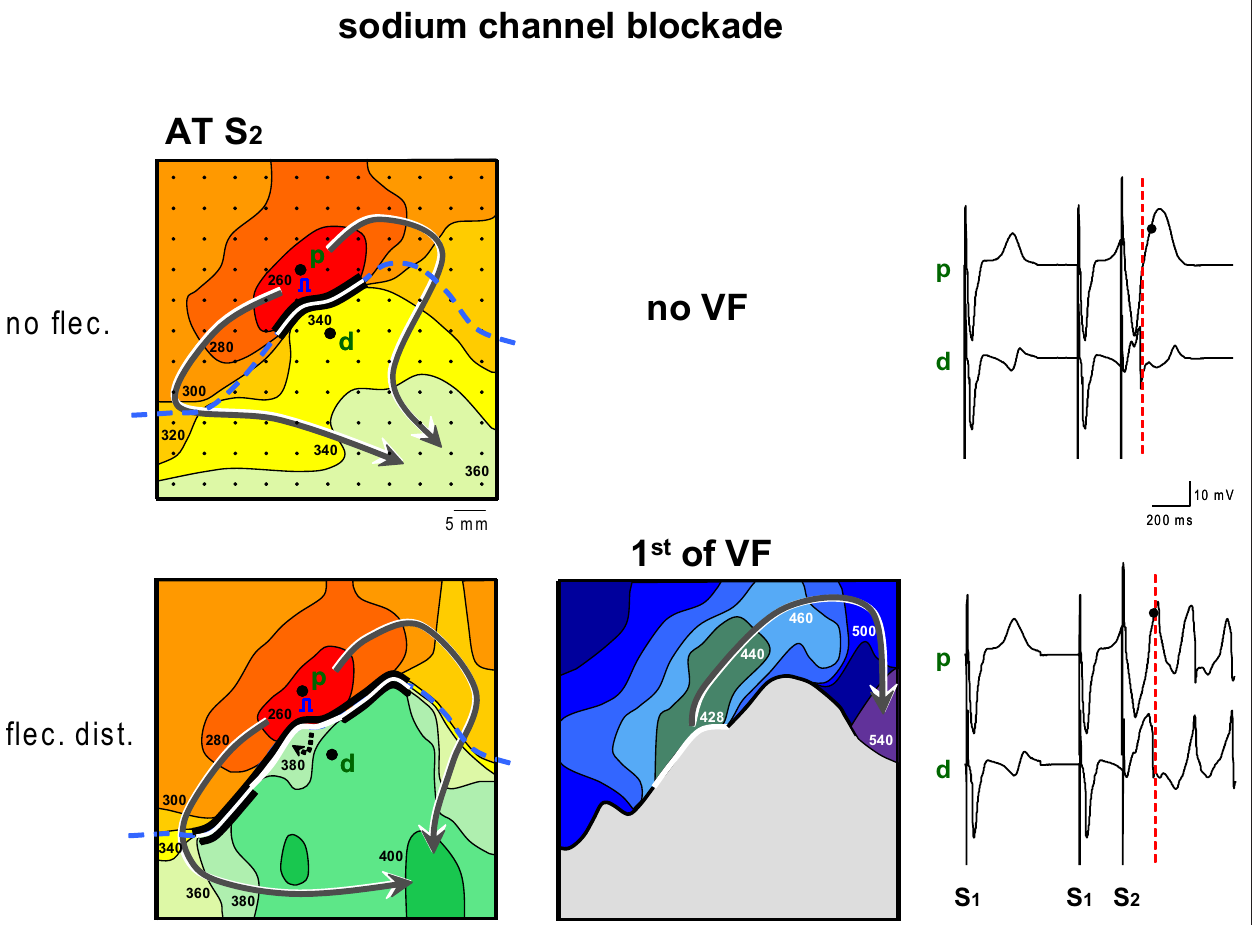
dashed line indicates the epicardial interface between the perfusion beds. Small dots indicate electrode positions. Bold dots indicate positions from which electrograms (right panels) were recorded (p, proximal; d distal). Lines are 20 ms isochrones. Red dotted vertical line in the electrograms indicate the moment of distal